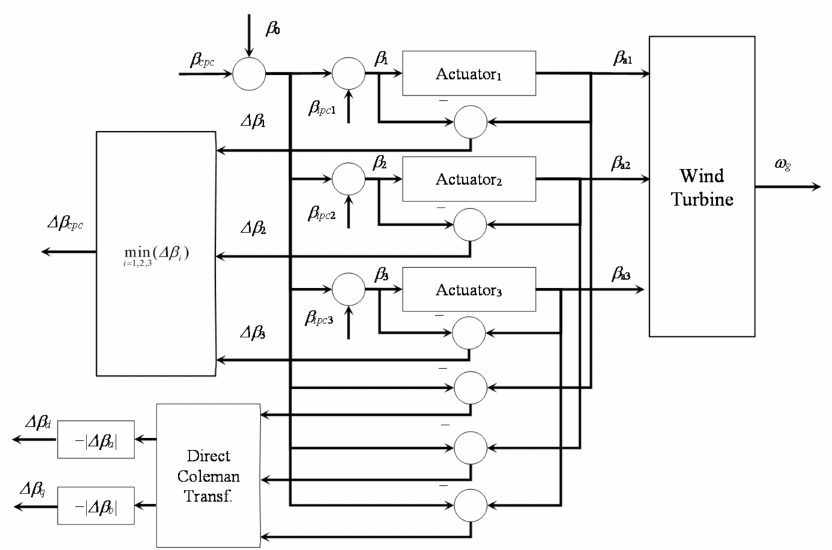
Figure 16. Anti-windup strategy for the whole pitch control system (CPC and